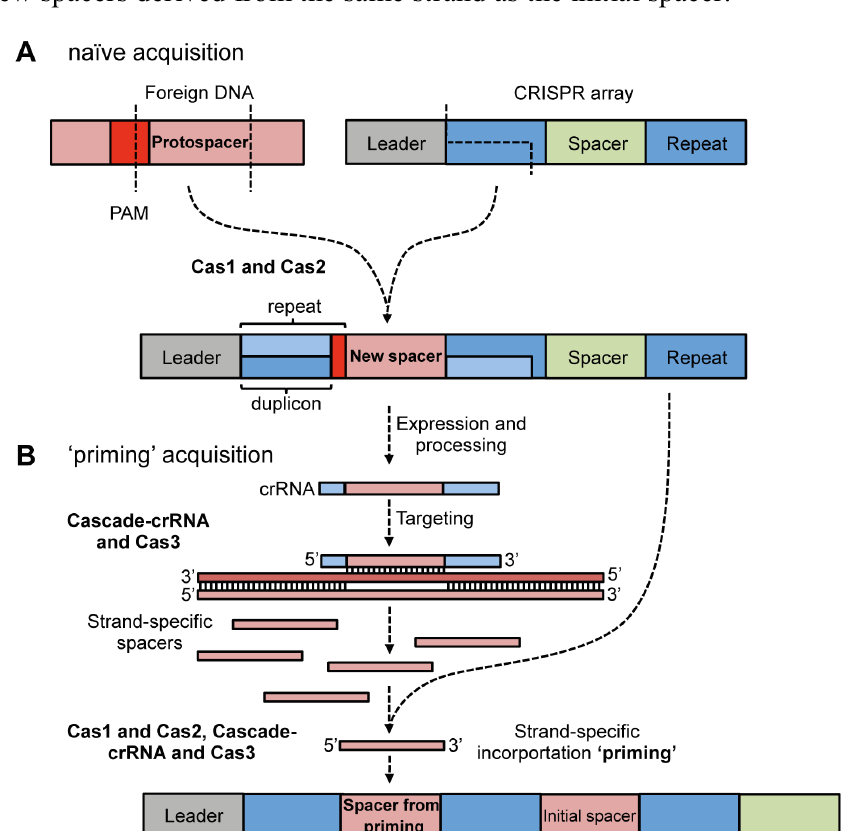
Figure 2. Model of CRISPR/Cas adaptation (based on type I-E systems). ( a )